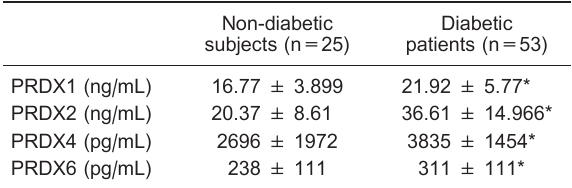
Table 2. Plasma levels of peroxiredoxin isoforms in non-diabeitc healthy control subjects and diabetic patients